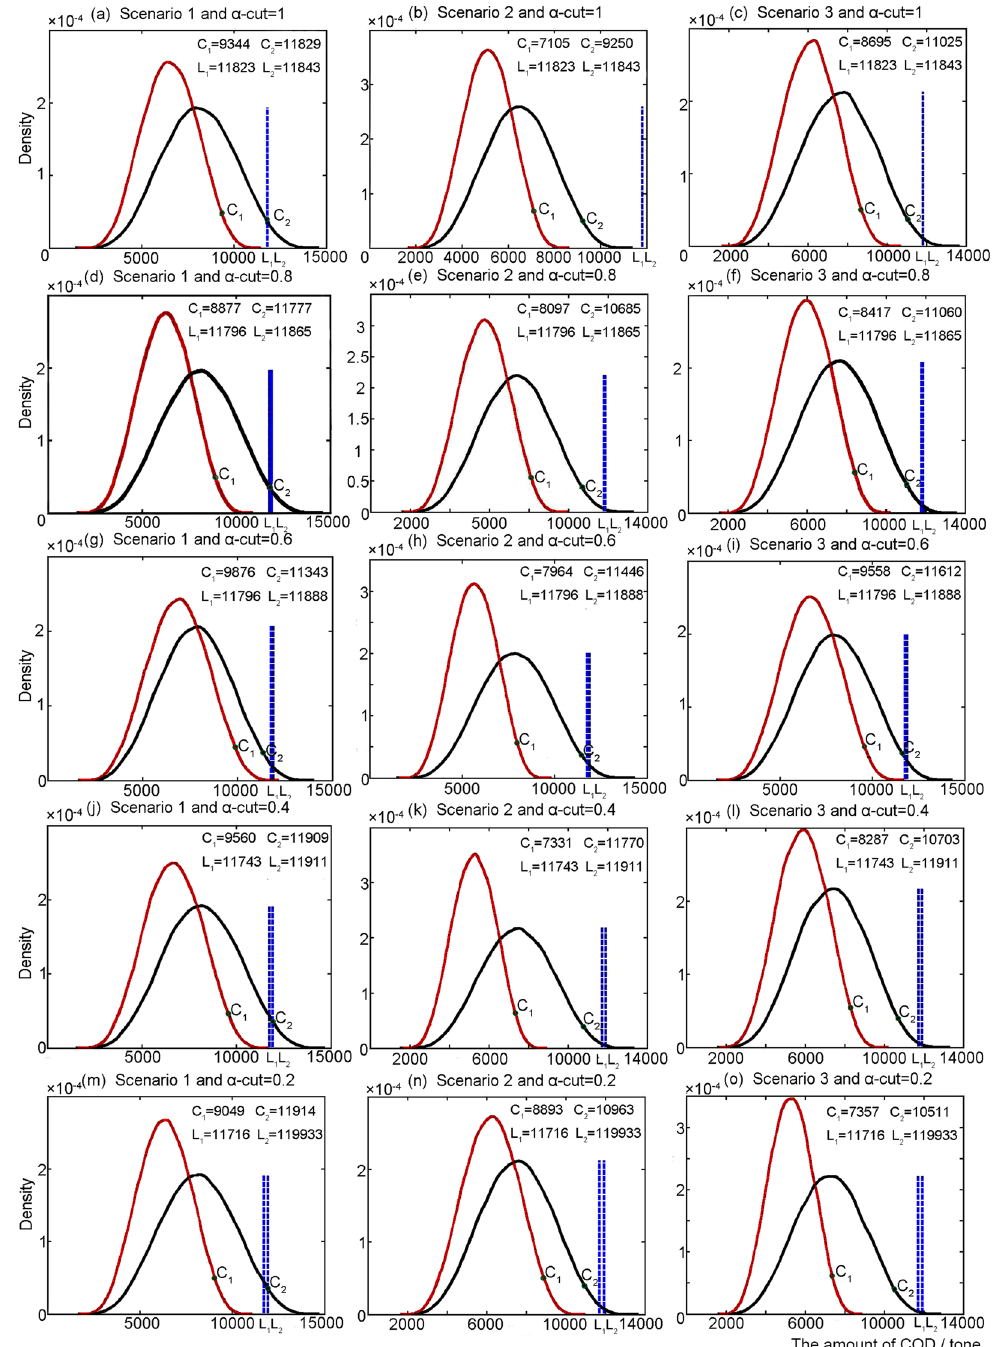
Figure 3. Violation risks of COD discharge in Scenarios 1 to 3. The parameters of C 1 and C 2 indicate probability of the incident (i.e., failure to meet total allowable target on wastewater discharge) would be 0.05. The parameters of L 1 and L 2 indicate the lower and upper bounds of discharge caps in